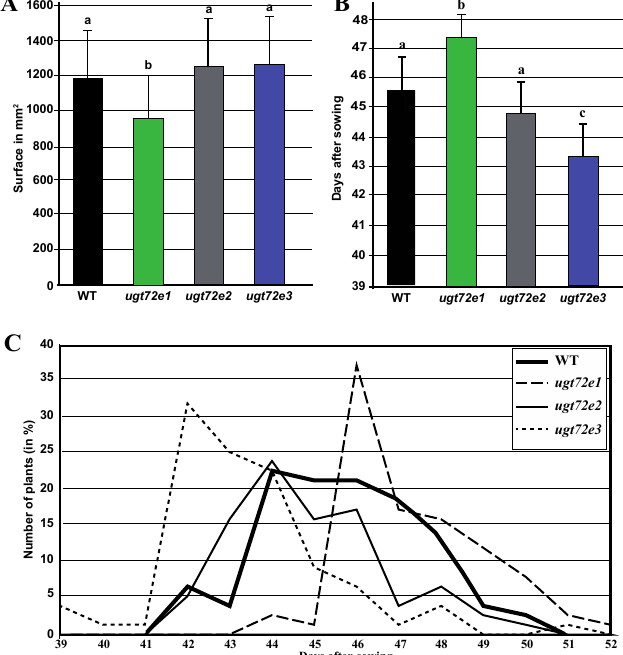
Figure 1. Effect of UGT72E gene mutation on the development of Arabidopsis thaliana . ( A ). Rosette surface sizes after 28 days of growth. ( B ). Average age of the plants when the flowering stem reached stage 5.1. ( C ): Distribution curve showing the ages of plants within the different genotypes at the flowering stem stage 5.1. Means (+ SD) with the same lowercase letters are not significantly different according to Anova completed with Tukey post-hoc test ( p -value < 0.01; n > 70).